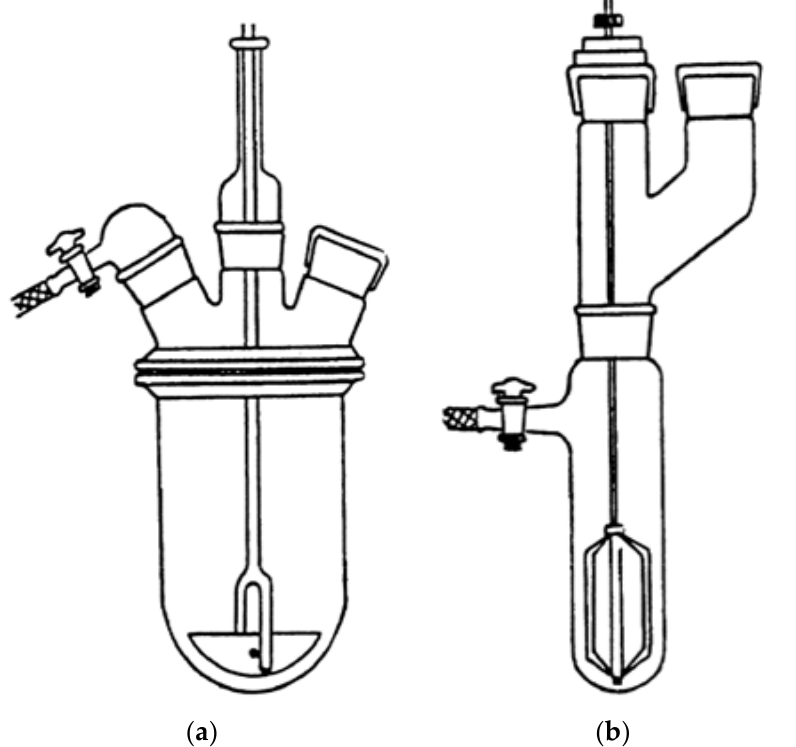
Figure 2. Reverse suspension polymerization apparatus for volumes in the range 400–850 mL ( a ) and for volumes < 80 mL ( b ). for volumes <80 mL ( b